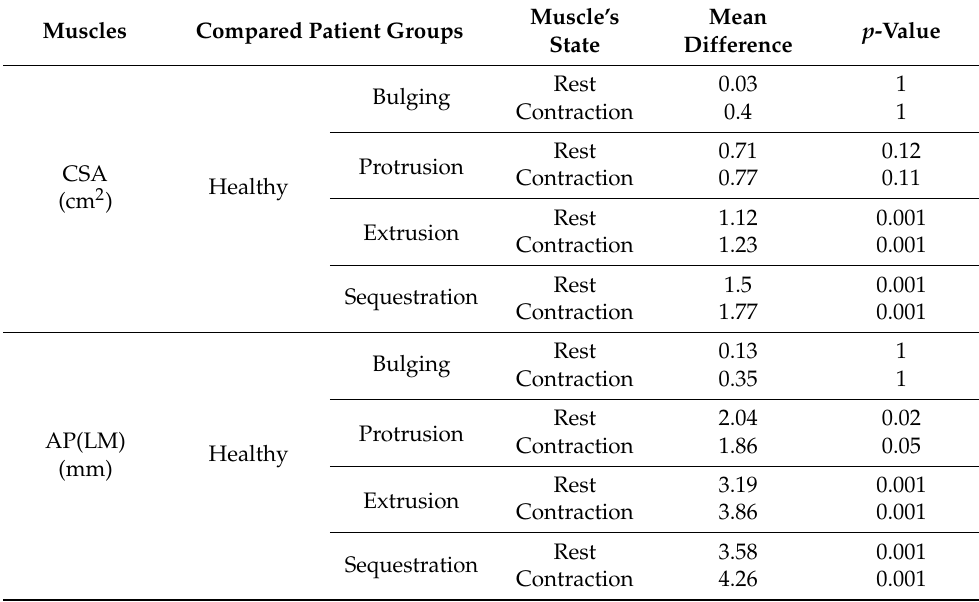
Table 3. LM muscles CSA and thickness changes comparison between different participant groups (at rest/contraction).